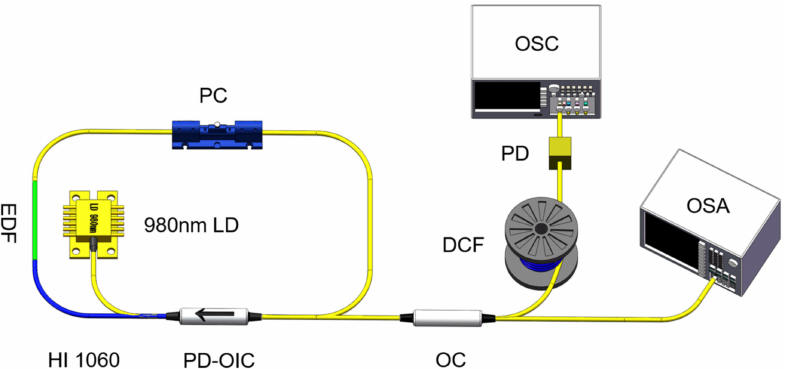
Figure 1. Our proposed ultrafast fiber laser and its measurement